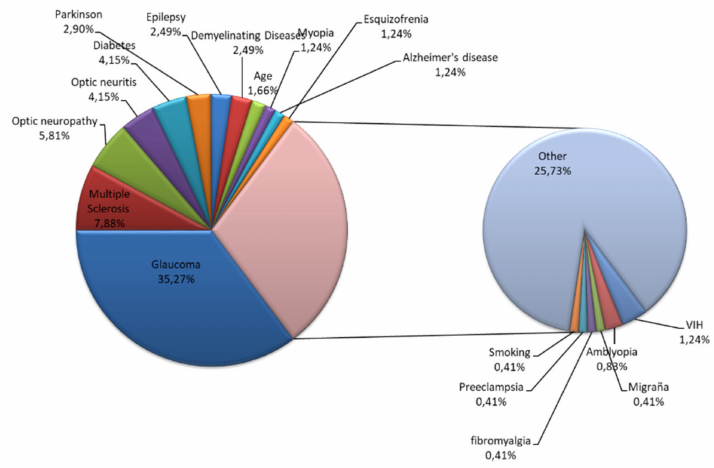
Figure 6. Distribution of the documents according to the main topic.